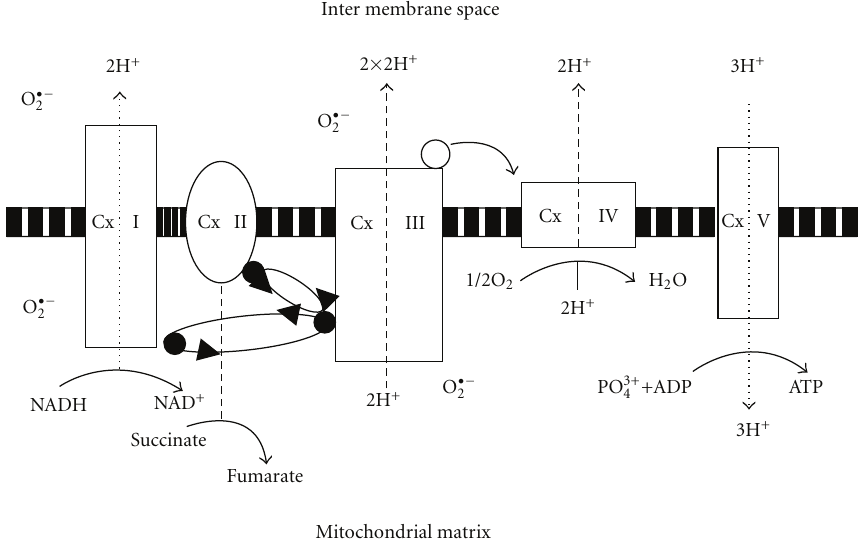
Figure 1: NAD(H)—the electron donor to complex I translocating protons across the membrane by a “steam engine” like mechanism producing ATP: the most important function of mitochondria alongside proton leaks for heat and energy dissipation and signals for autophagy and apoptosis. Many mutations that a ff ect mitochondrial complex 1, or, microtubular function and kinases and autophagy/mitophagy and radical production contribute to rare forms of ageing diseases such as PD in a vicious cycle subverting normal quality controls that a ff ect proteosomal homeostasis. In the case of Parkinsons’, increasing NADH levels may drive excessive dopamine synthesis to toxic levels by enhancing the recycling of the cofactor for tyrosine hydroxylase.